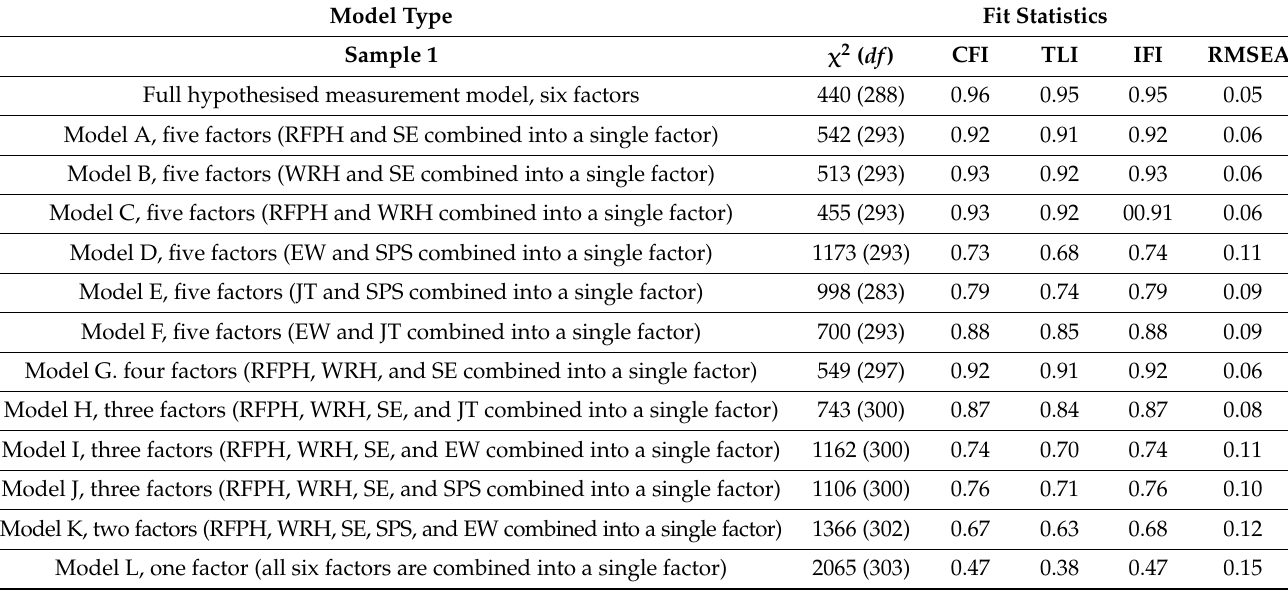
Table 2. Measurement model results.